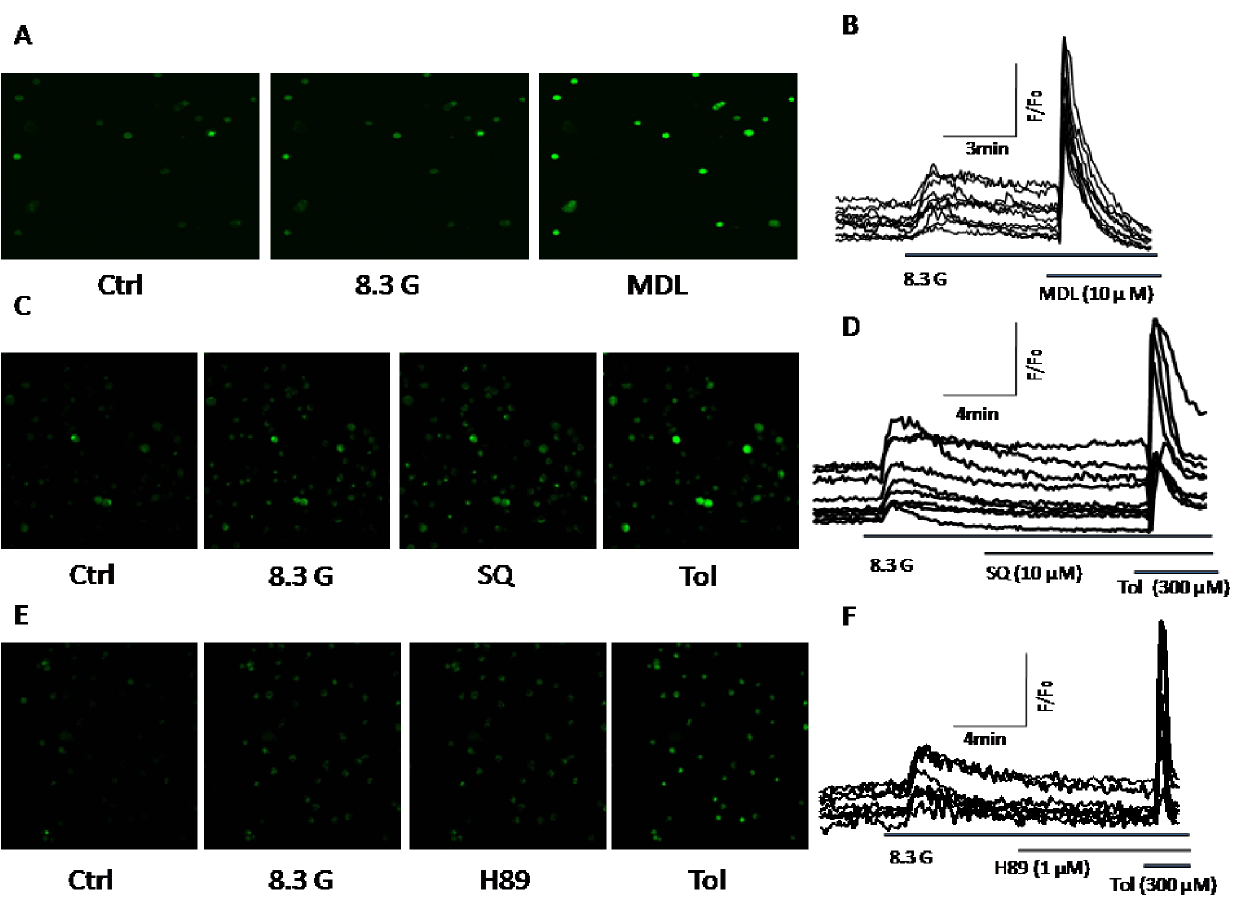
Figure 7. MDL-12,330A increases [Ca 2 + ] i level. [Ca 2 + ] i was measured from beta cells loaded with Fluo 4-AM using a laser scanning confocal microscope at room temperature. The ratio of fluorescence change F/F 0 was plotted to represent the change in [Ca 2 + ] i levels. A, B. cells were treated with 10 m M MDL-12,330A (MDL, n=10) in the presence of 8.3 mM glucose (8.3G). C, D. Cells were treated with 10 m M SQ 22536 (SQ, n=9) in the presence of 8.3 G. E,F. cells were treated with 1 m M H89 (n=8) in the presence of 8.3 G. As a positive control, Tolbutamide (Tol, 300 m M) was applied after SQ 22536 or H89 treatments.